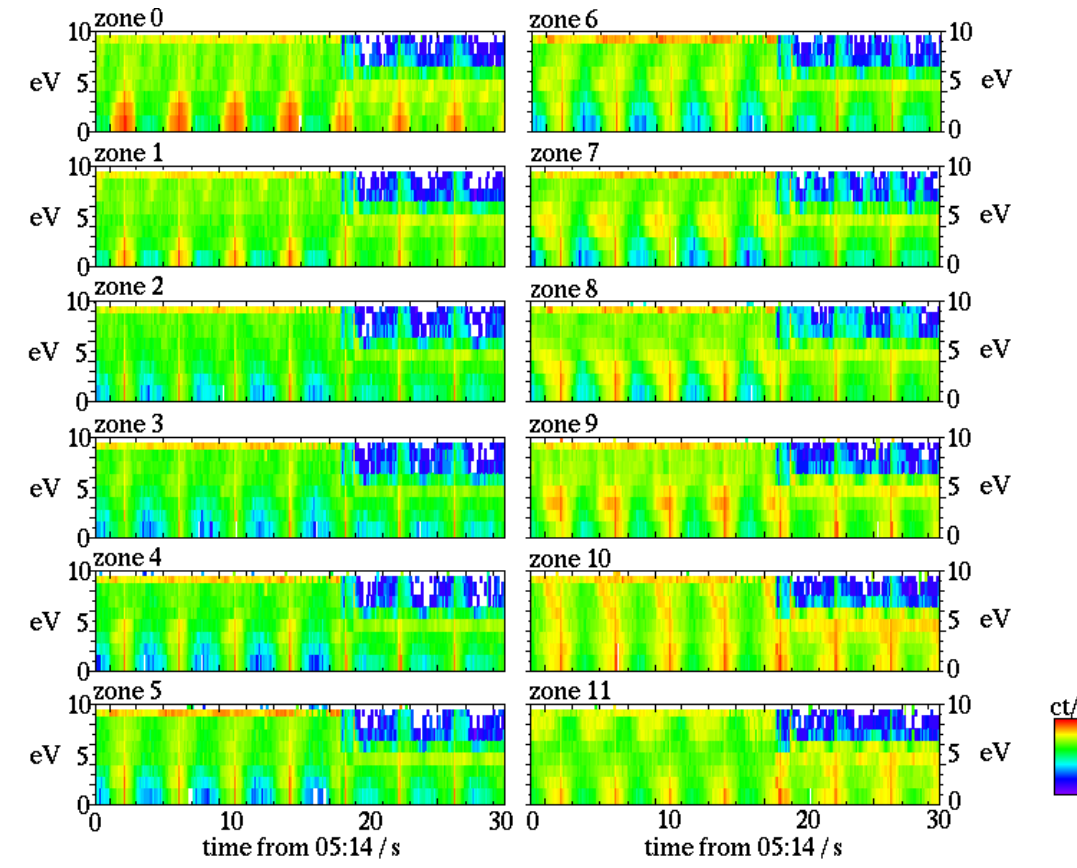
Fig. 6. High resolution 3DX PEACE data showing the effect of ASPOC being switched on, one panel for each anode.